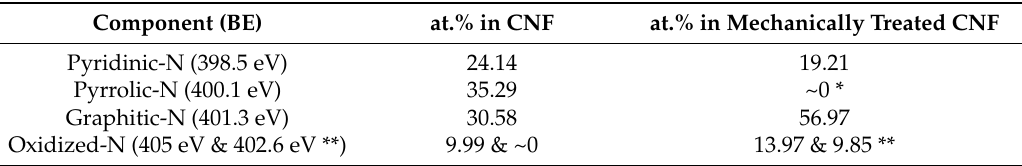
Figure 4. ( a ) Fitting N 1s X-ray photoelectron spectroscopy (XPS) peak of CNF, ( b ) Fitting N 1s XPS peak of mechanically treated CNF. Table 1. Nitrogen species based on XPS analysis.